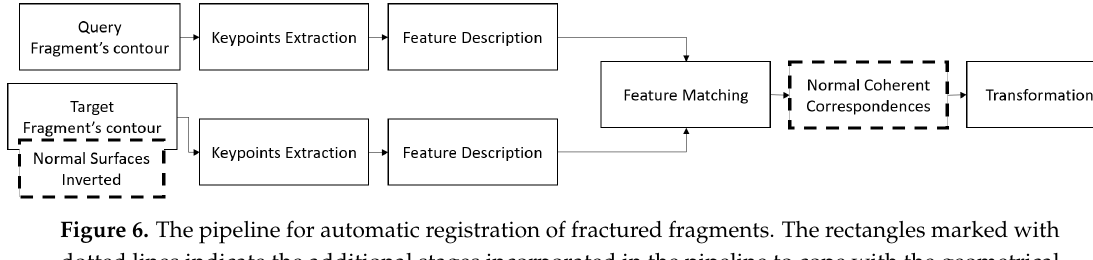
Figure 6. The pipeline for automatic registration of fractured fragments. The rectangles marked with dotted lines indicate the additional stages incorporated in the pipeline to cope with the geometrical constraints of heritage